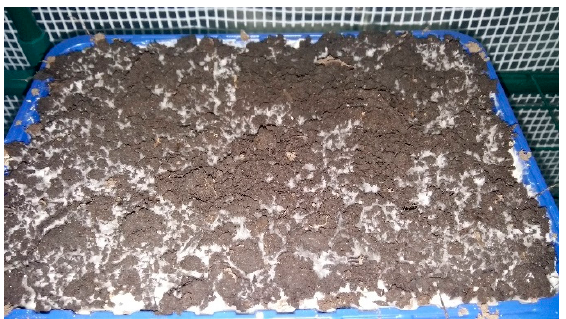
Figure B3. ( left ) Covering the mycelium coated substrate; ( right ) covered compost trays. Source: Photo original—SC CIUPERC Ă RIA SRL, Aghiresu-Fabrici, Cluj County.